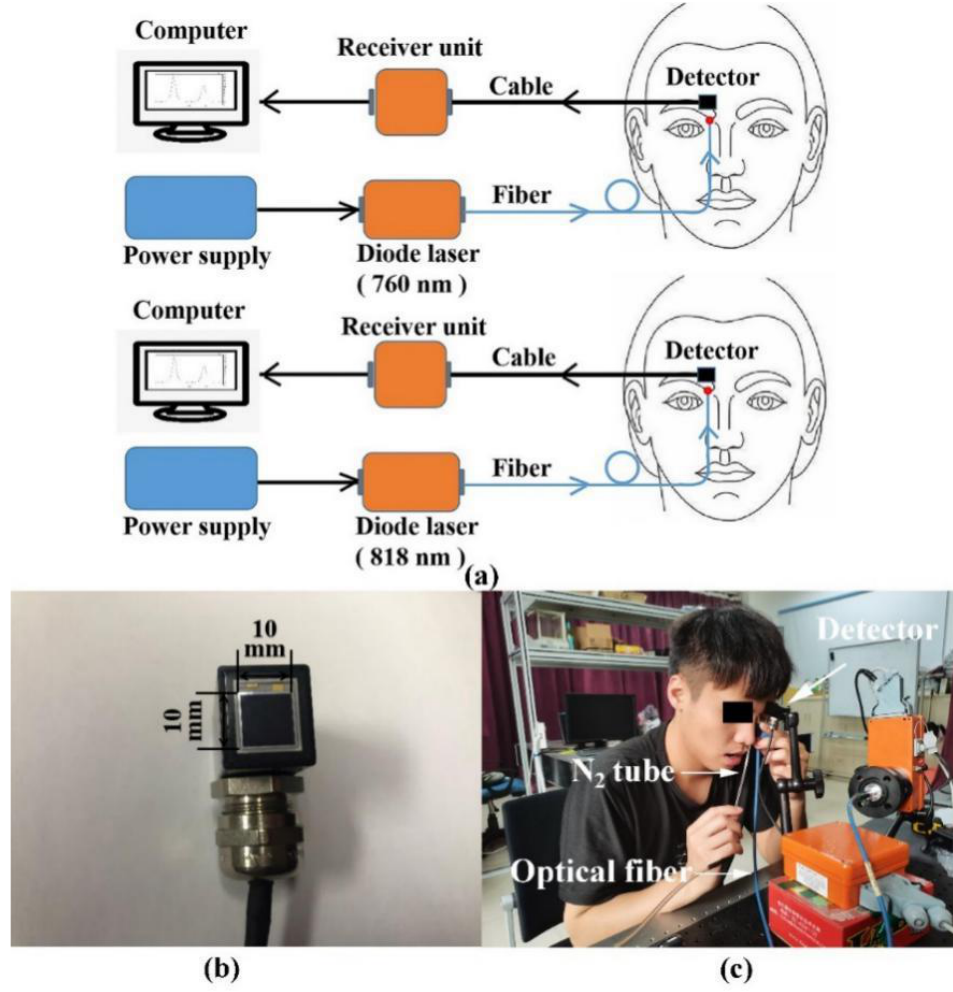
Figure 3. ( a ) Diagram of the arrangement of the two GASMAS systems with lasers, emitting light at 760 nm and 818 nm, respectively. ( b ) Photograph of the detector. ( c ) Photograph of the systems during measurement.